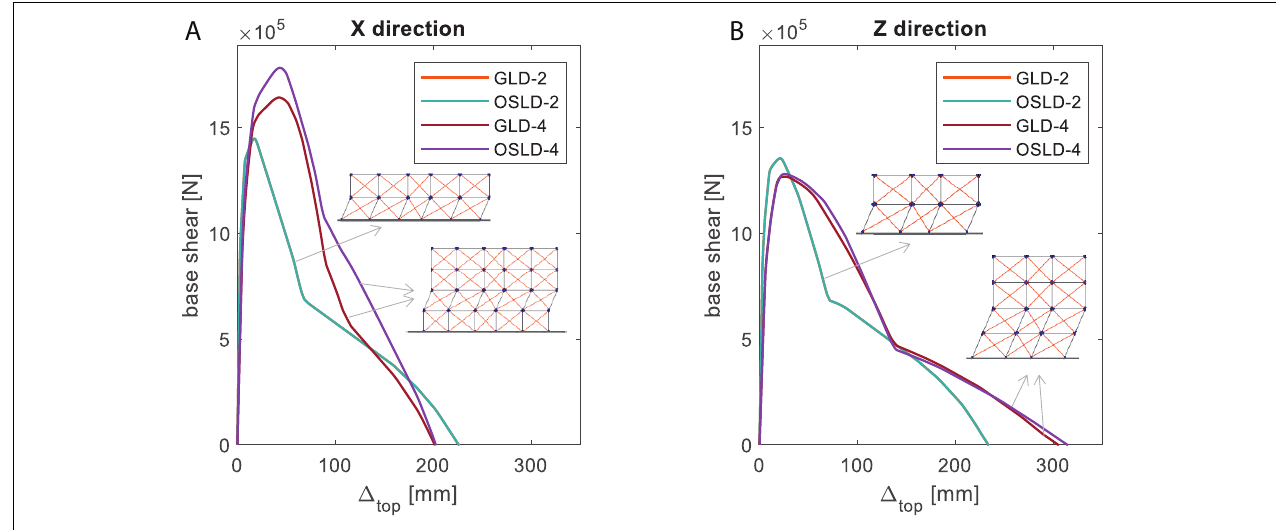
FIGURE 5 | SPO curves and related collapse mechanisms for the case study buildings: longitudinal (X) direction (A) , and transverse (Z) direction (B)